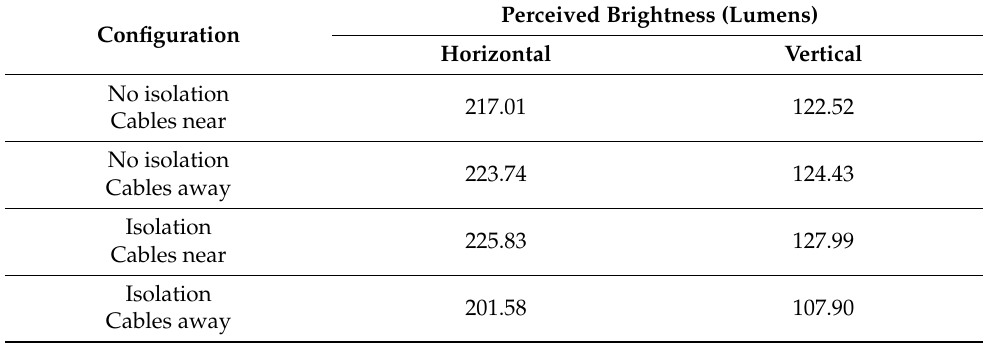
Table 2. Perceived brightness for mitigation efforts.